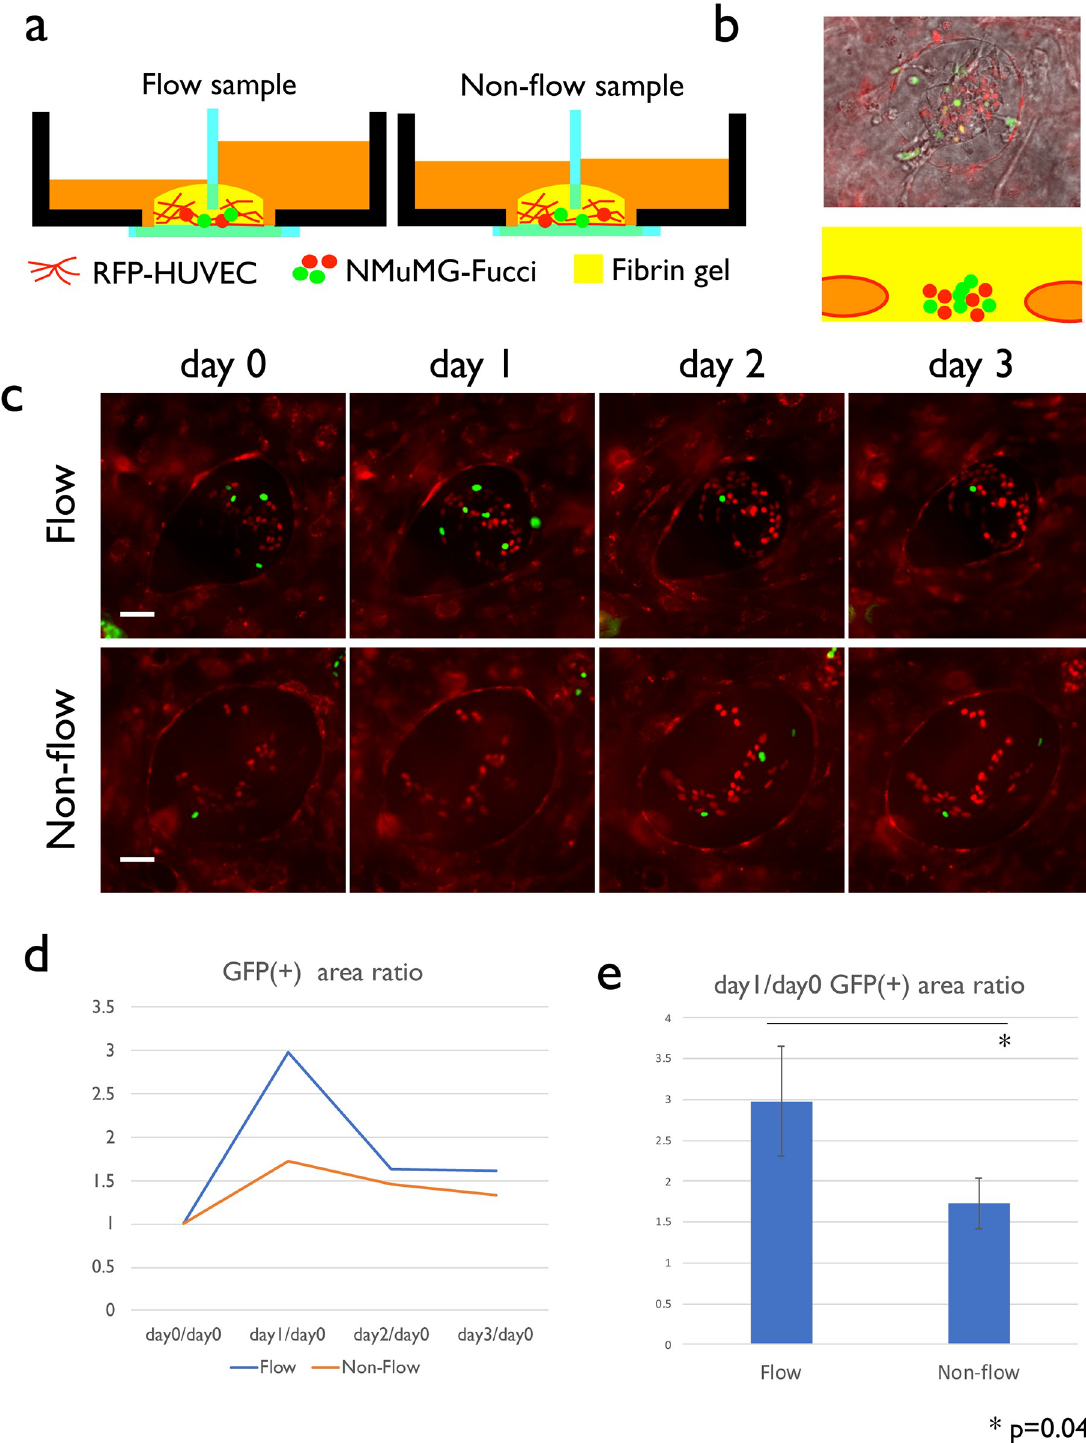
Fig 4. Effect of flow on cell proliferation. (a) Experiment setup. We prepared two groups of dishes in which a mixture of RFP-HUVECs and NMuMG-Fucci cells were seeded in the fibrin gel. After the perfusable network was formed, we made openings to both groups but transferred medium in only one group of the dishes. (b) Typical appearance of the NMuMG cell colony and its schematic representation. NMuMG-Fucci cells (red and green nuclei) forms colonies outside the vascular lumen. (c) Time course of the cell division monitored by Fucci reporter. (d) Time course of GFP(+) area ratio. 20 NMuMG-Fucci colonies were observed, and the area of GFP(+) areas was obtained using Fiji. (e) GFP(+) area ratio between day 1 and day 0. Statistically significant difference was detected (Student t-test). Scale bars: 50 μ